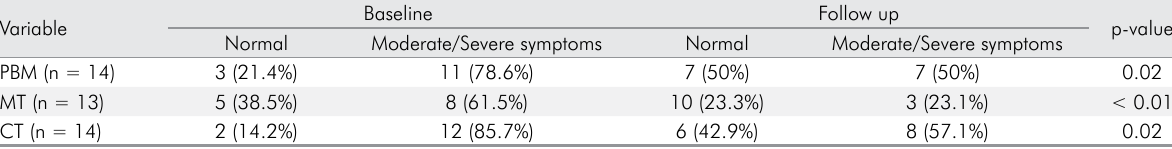
Table 6. RDC axis II: Assessment of D3a (nonspecific physical symptoms with pain).